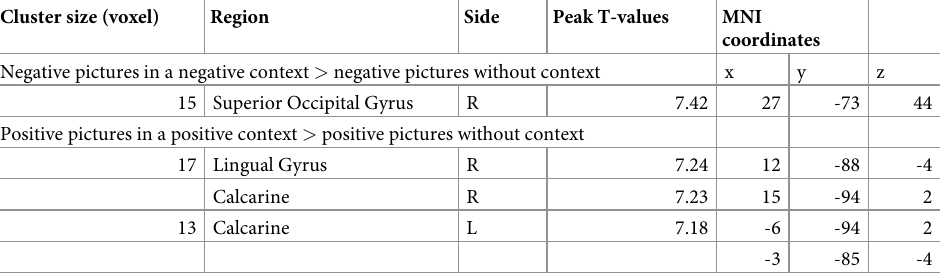
Table 3. Brain regions showing significantly increased activation to positive pictures in a positive context were compared to positive pictures without context (P1P2 picture pairs), and those with significantly increased activa- tion to negative pictures in a negative context were compared to negative pictures without context (N1N2 picture pairs). Cluster size (voxel) Region Side Peak T-values MNI coordinates Negative pictures in a negative context > negative pictures without context x y z 15 Superior Occipital Gyrus R 7.42 27 -73 44 Positive pictures in a positive context > positive pictures without context 17 Lingual Gyrus R 7.24 12 -88 -4 Calcarine R 7.23 15 -94 2 13 Calcarine L 7.18 -6 -94 2 -3 -85 -4 Note. R = right, L = left; the statistical threshold was set to p < .05, family-wise error (FWE) corrected for multiple